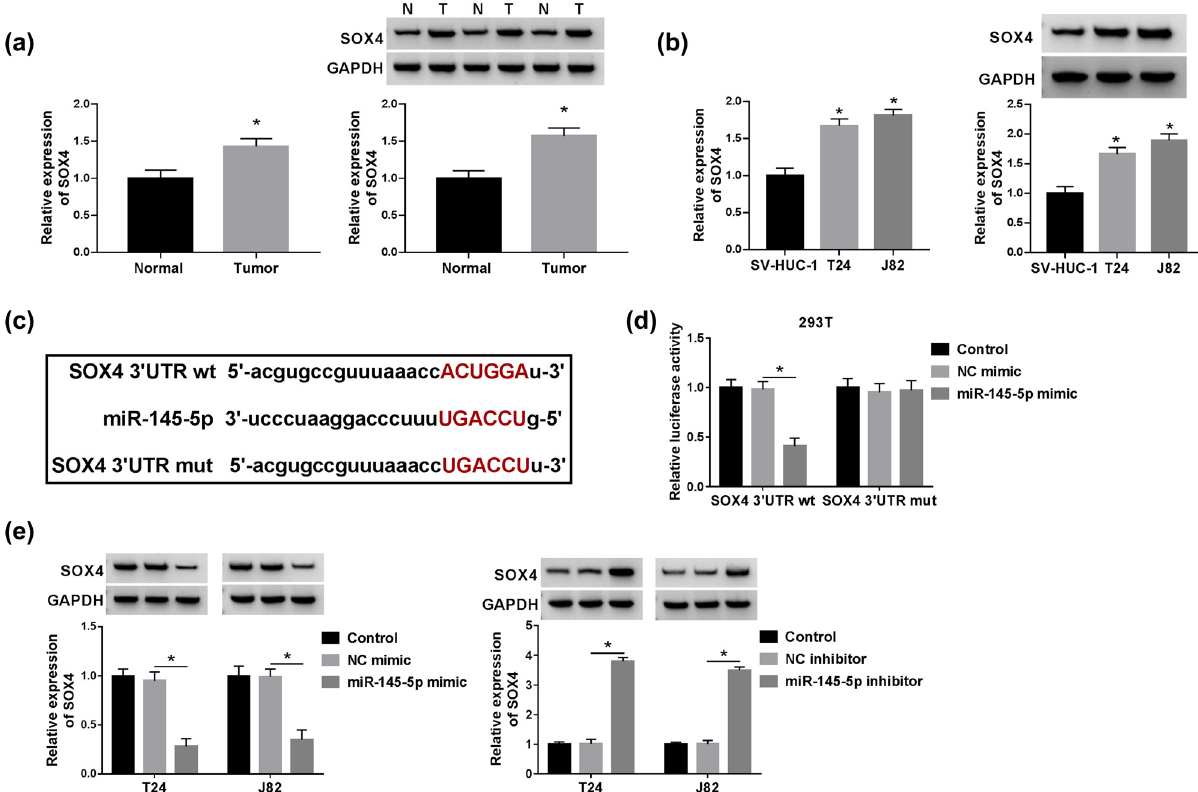
Figure 5: SOX4 was directly targeted and inhibited by miR - 145 - 5p. ( a ) The mRNA and protein levels of SOX4 in bladder cancer tissues ( n = 36 ) and normal tissues ( n = 36 ) were detected by RT - qPCR and western blot. ( b ) The mRNA and protein levels of SOX4 in SV - HUC - 1, T24, and J82 cells were measured by RT - qPCR. ( c ) The putative or mutant miR - 145 - 5p binding sites in the 3 ′ UTR of SOX4 were predicted by Targetscan tool. ( d ) 293T cells were co - transfected with NC - mimic or miR - 145 - 5p mimic and SOX4 3 ′ UTR wt or SOX4 3 ′ UTR mut, and the luciferase activity was detected. ( e ) T24 and J82 cells were transfected with NC - mimic, miR - 145 - 5p mimic, NC inhibitor, or miR - 145 - 5p inhibitor, respectively. And the expression level of SOX4 was examined by western blot. * P <